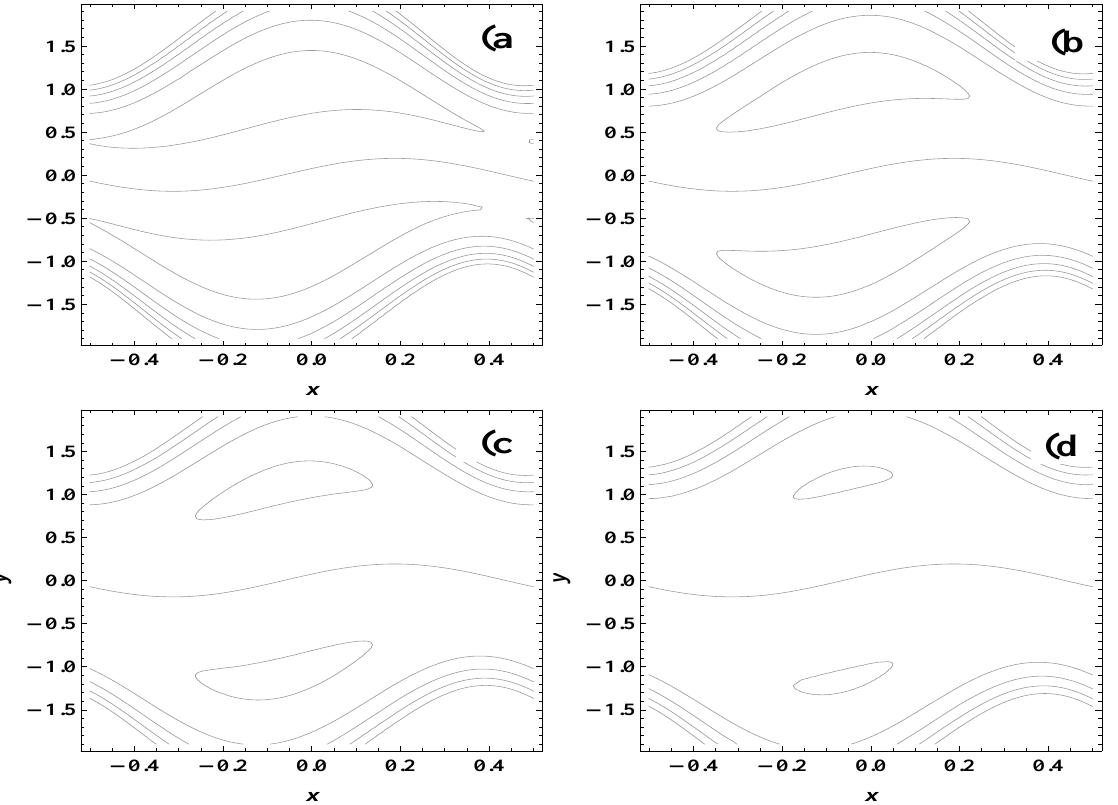
Figure 9. Effect on trapping by λ 1 with Q = 1.48, ϕ = π /4, M = 1, λ 1 = 1 (a); β 1 =0,(b); β 1 =0.1,(c); β 1 =0.2,(d); β 1